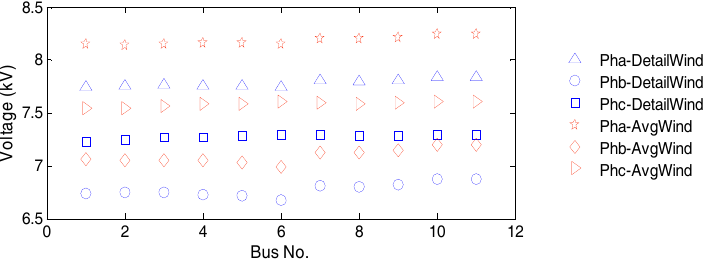
Figure 16. Comparison of DFIG models in steady state operating phase RMS voltages for islanded operation before switching the capacitors.